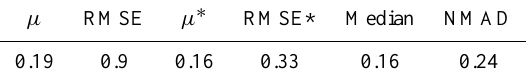
Table 1. Statistical accuracy measures of error distributions (DSM ADS –DTM ALS ) for 886000 points at the test site Wannen- grat (* outlier removal: ≥ µ ± 3 ×